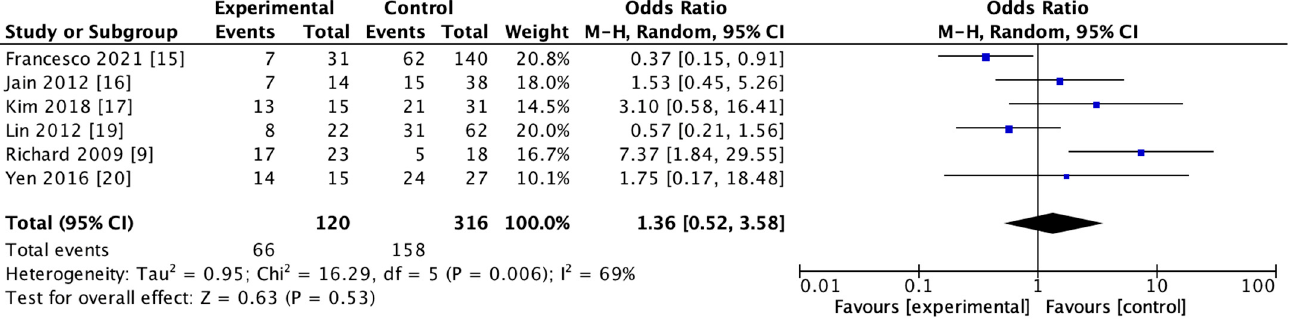
Figure 5. Forest map of recombinant tissue plasminogen activator (rt ‐ PA) usage in HT and non ‐ HT groups .